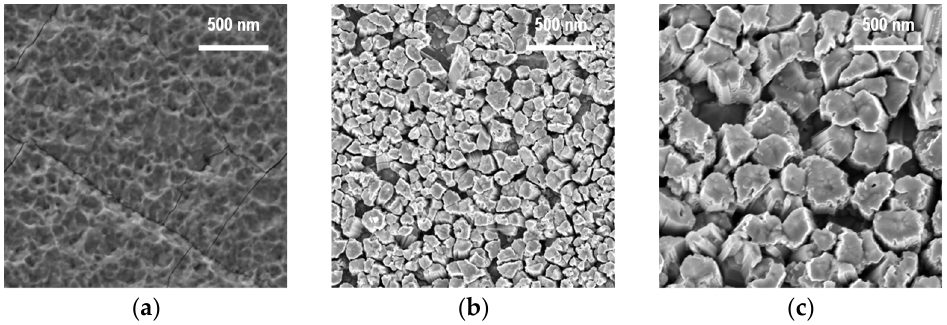
Figure 7. SEM images of ZnO nanopowders obtained by the PECVD method at various temperatures in the reactor deposition zone: ( a ) 25 °C, ( b ) 250 °C, ( c ) 350 °C.